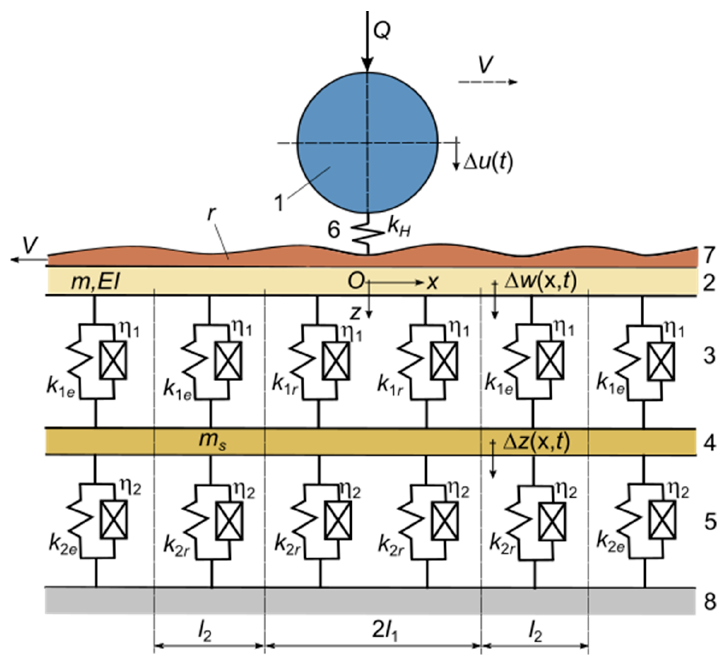
Figure 4. The mechanical model for the study of wheel–rail vibrations: (1) the wheel; (2) rail; (3) rail pads; (4) sleepers; (5) ballast prism; (6) elastic wheel–rail contact; (7) roughness; (8) rigid base.